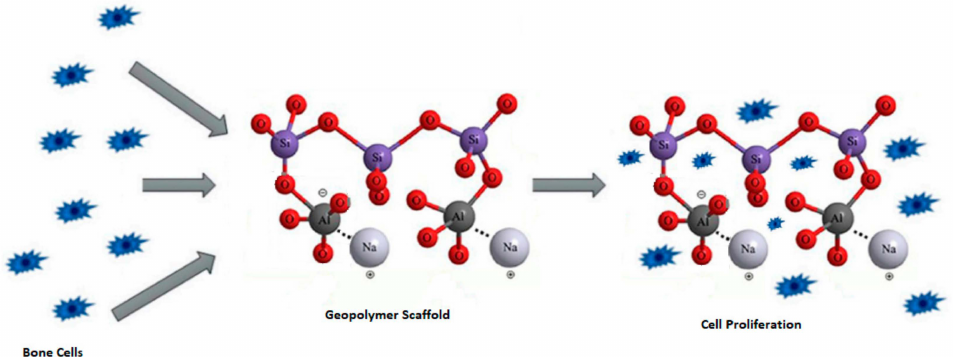
Figure 2. Outline of bone cell proliferation within geopolymer